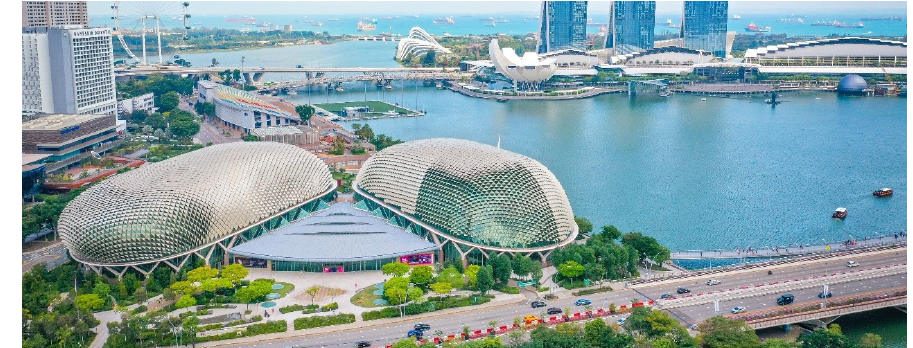
Figure 9. Singapore Arts Centre with the Concert Hall and the Lyric Theatre